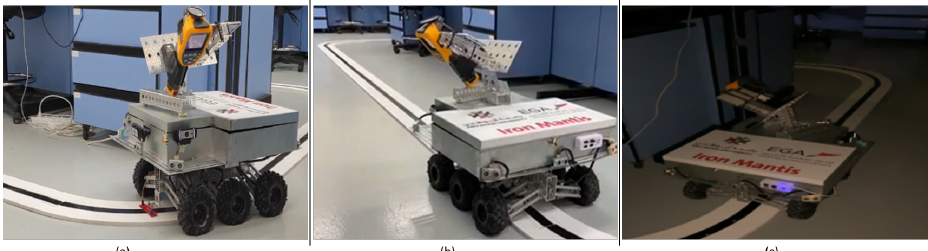
Figure 19. The Line Follower algorithm results in the lab environment: ( a ) shows the robot following the track and turning around the center bench while ( b ) shows the robot while it continues after turning and moves forward. ( c ) shows the results of testing the line follower algorithm under different lighting conditions.